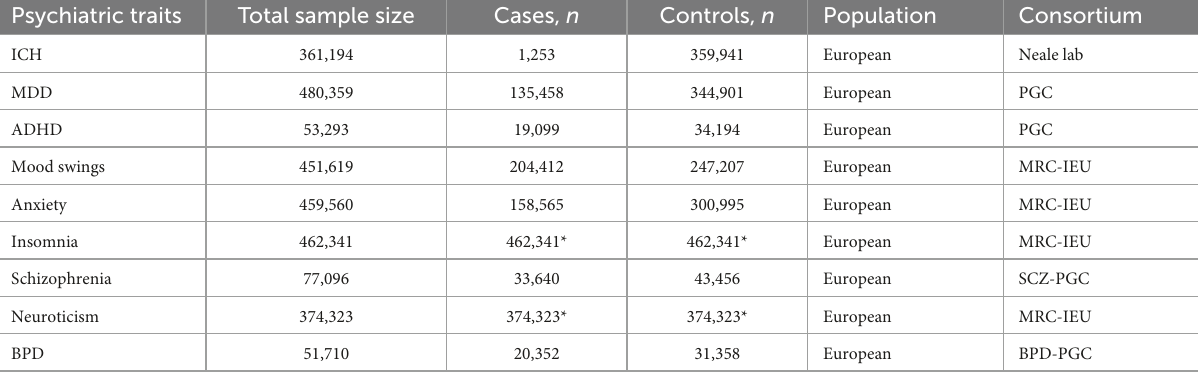
TABLE 1 Details from GWAS data.